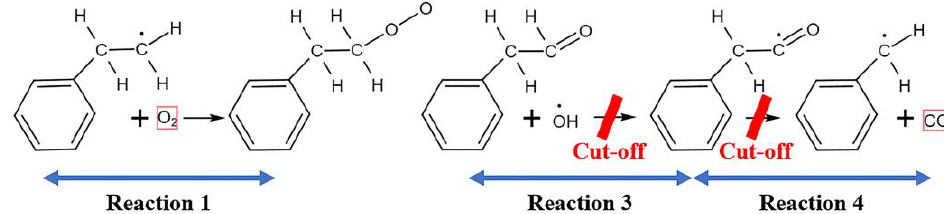
Figure 12. Inhibition mechanism on